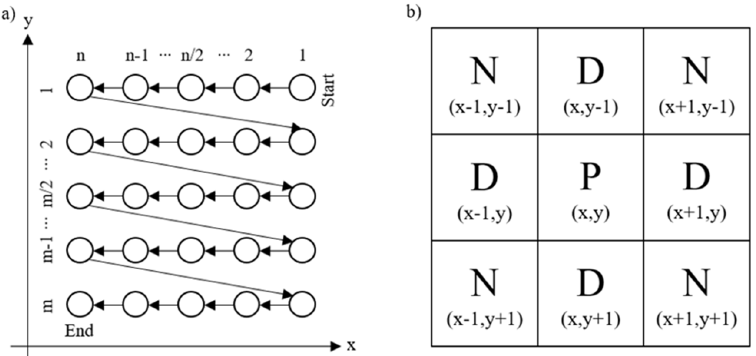
Figure 3. The schematic representation of the standard drilling sequence of a drilling array ( a ) and ( b ) the used Moore neighborhood relation around P with two horizontal and two vertical (D) and four diagonal neighbors (N).